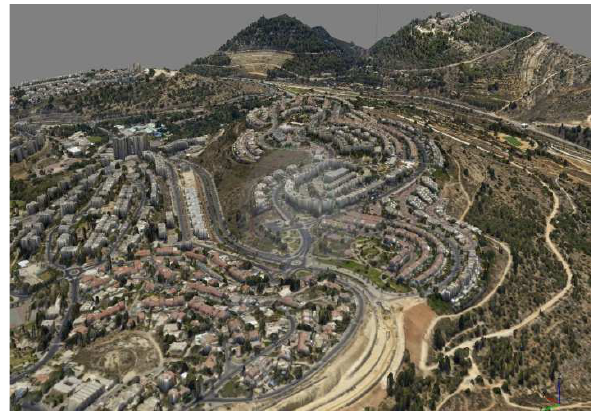
Figure 9: 3D result as coloured point- cloud of the DSM of